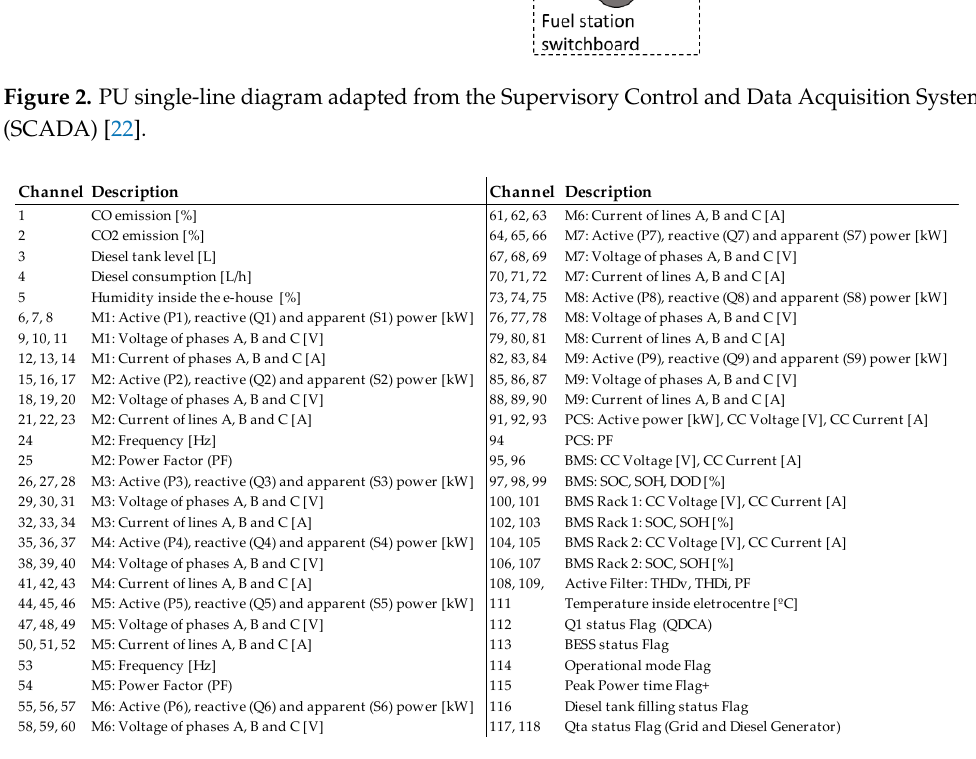
Figure 3. Measurement description